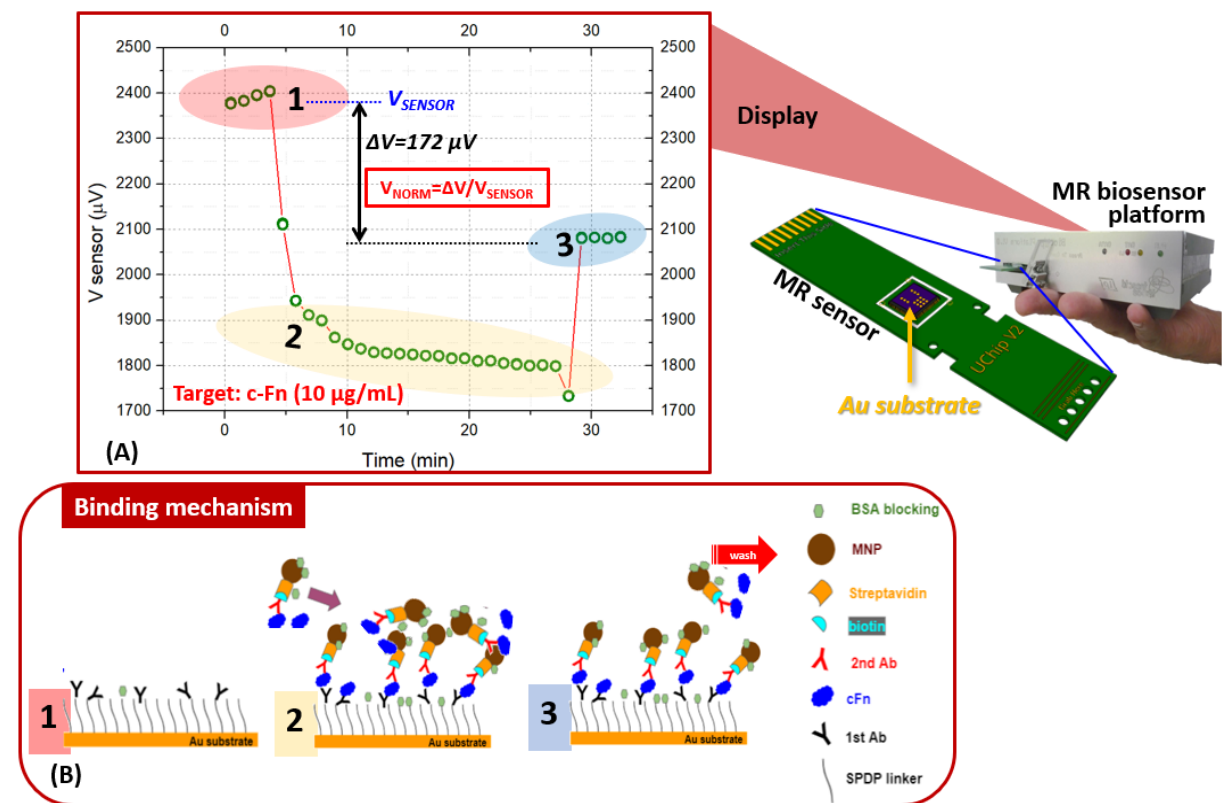
Figure 3. Illustration of: ( A ) a representative image of the binding signal measurement obtained for c-Fn using a portable MR biochip as a sensing element. ( B ) the sandwich assay strategy occurring on the gold surface of a MR sensor.